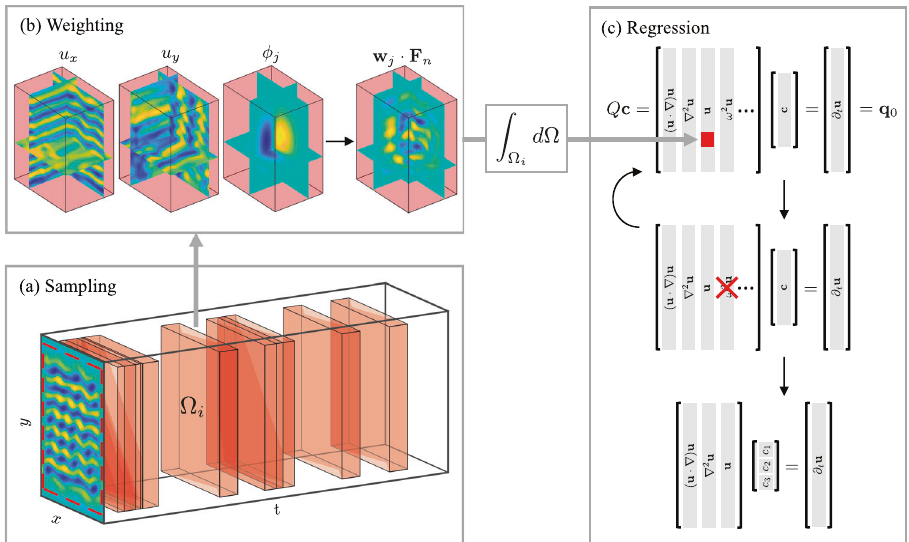
Fig. 2 Symbolic regression algorithm based on weak formulation. a Integration domains, shown as red boxes, are randomly sampled throughout the 2D space-1D time data set. b For each integration domain Ω i , the data u ¼ u x ^ x þ u y ^ y and the weights w j ¼ ∇ ´ ½ ϕ j ^ z (cid:2) are used to evaluate the scalar product 〈 w j ⋅ F n 〉 , as discussed in the “ Methods ” section. The result determines the matrix element Q kn (for n ≠ 0) or the k -th element of q composite index k runs over all integration domains i and weights j . The columns are labeled using the corresponding terms in the model instead of the index n to make the relation with the linear system (6) more transparent. c A sparse solution to the system is then found via sequential thresholding, where one (or more) columns are removed from the matrix Q (and the model) at each iteration, until a parsimonious model balancing accuracy with simplicity is identi fi ed (bottom of ( c